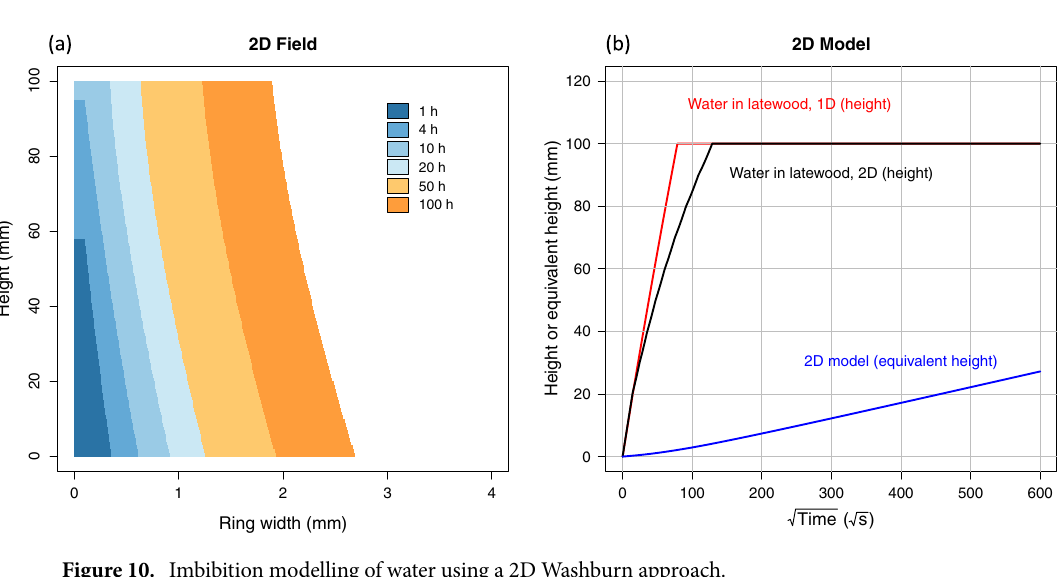
Figure 10. Imbibition modelling of water using a 2D Washburn